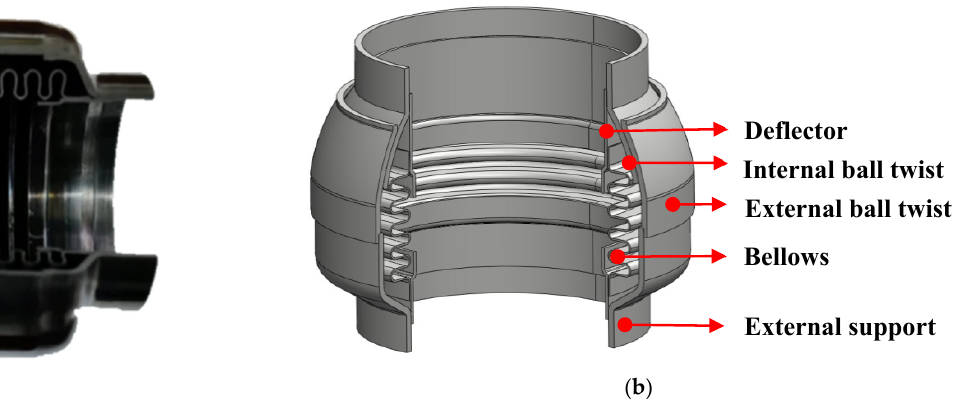
Figure 1. Schematic illustration of a ball joint: ( a ) sectional view; ( b ) structure of the ball joint. The ball joint is used as a stress compensator in the air duct to alleviate the stress concentration of the duct system. From a qualitative point of view, there is a bending friction torque of the ball joint. If the bending moment of the joint is greater than the bending friction torque, the joint begins to bend. The angle of bending has a certain linear relationship with the bending moment, as shown in Figure 2. The bending friction torque and bending stiffness are important parameters for evaluating the bending characteristics of the ball joint. The degrees of freedom of the ball joint are listed in Table 1. The ball joint has no axial displacement degrees of freedom, but only rotational degrees of freedom.